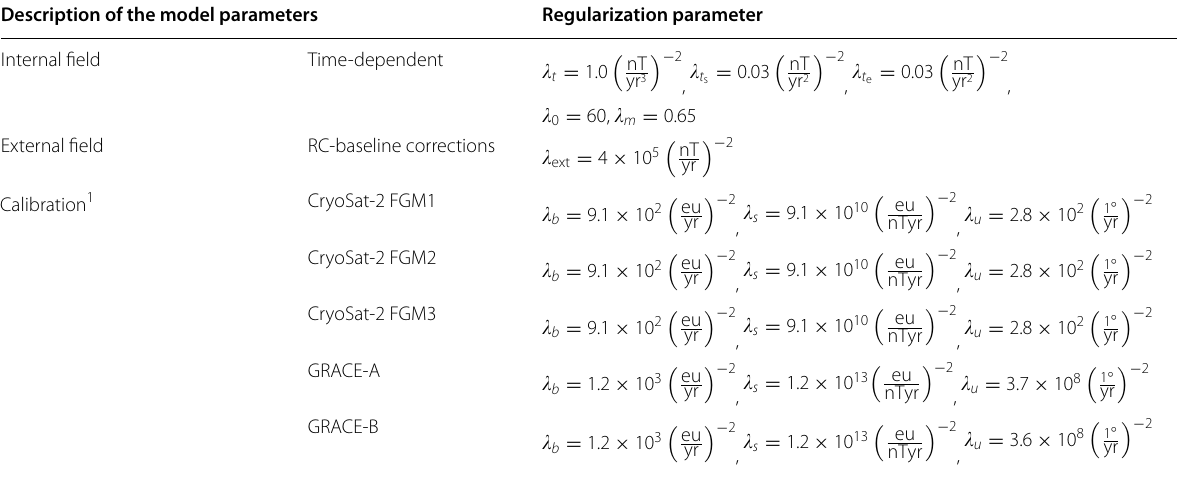
1 Not applicable to Model-A, which was not derived from platform magnetometer data